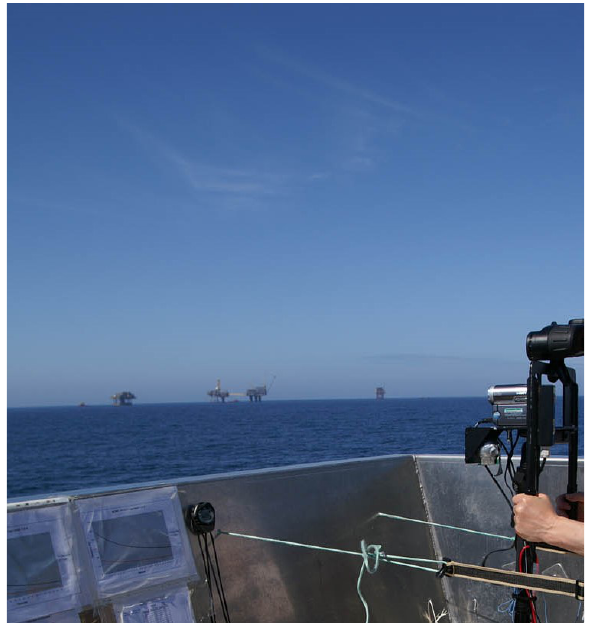
Figure 9. Bizarre creatures rise from the horizon (Photo: G. Desportes). Whales alone or in groups, dolphins breaching the surface and coming by to bow-ride for a while. Humpback whales foraging and breaching, accompanied by their flocks of scavenging sea birds. Pilot whales spy-hopping. Fin whales swimming at their energetic and powerful pace, splitting the surface and diving again, generously offering up their right jaw so they can be identified with certainty. Calves bow-riding adults. Motionless sperm whales resting, recovering their breath. Majestic flukes sinking under the dark surface. Large flocks of dolphins—3 or 4 hundred animals (how will we count them?)—passing the ship, streaming by for minutes on end, spiralling in the bow waves, moving from bow to stern, from port to starboard and back again, fascinating and confusing. Don’t forget to count them: how many calves?